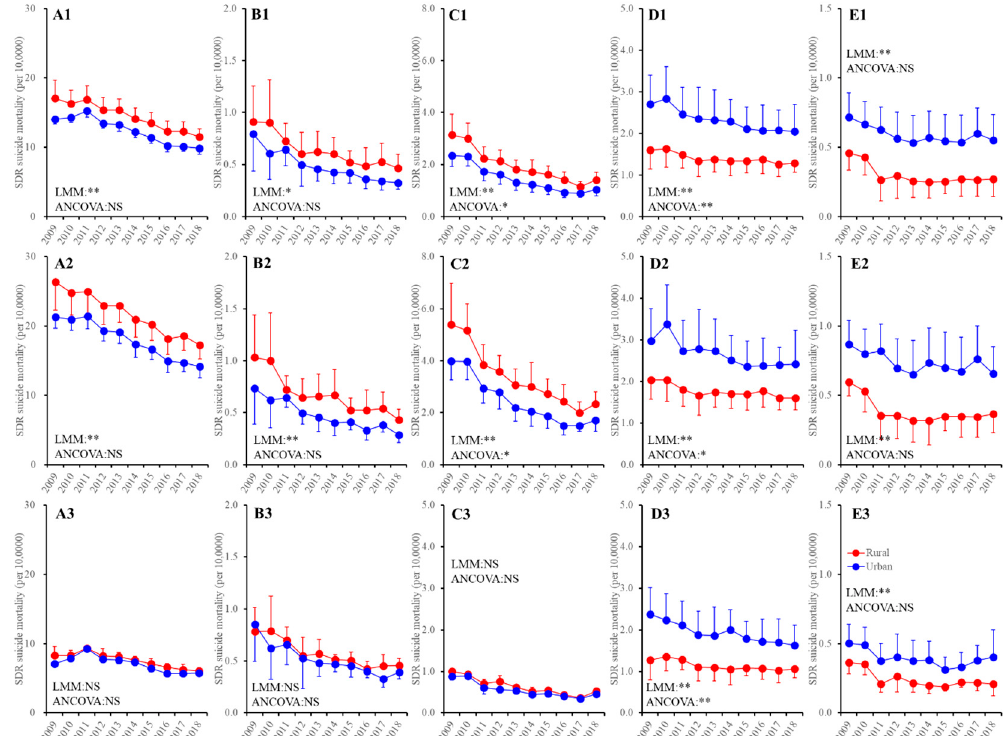
Figure 6. Trends of suicide mortalities by hanging ( A1 –A 3 ), poisoning ( B1 –B 3 ), charcoal burning ( C1 –C 3 ), jumping ( D1 – D 3 ) and throwing ( E1 –E 3 ) disaggregated by gender factor, males + females ( A1 – E1 ), males ( A2 – E2 ) and females ( A3 – E3 ) during 2009–2018. Ordinates indicate mean ± SD of SDR suicide mortality rate (per 10,000), and abscissas indicate year. * p < 0.05, ** p < 0.01 indicate the statistically significant differences between rural (red circles) and urban (blue circles) prefectures of suicide mortality by linear mixed-effect model (LMM) with Scheffe’s multiple comparison and analysis of co-variant (ANCOVA).